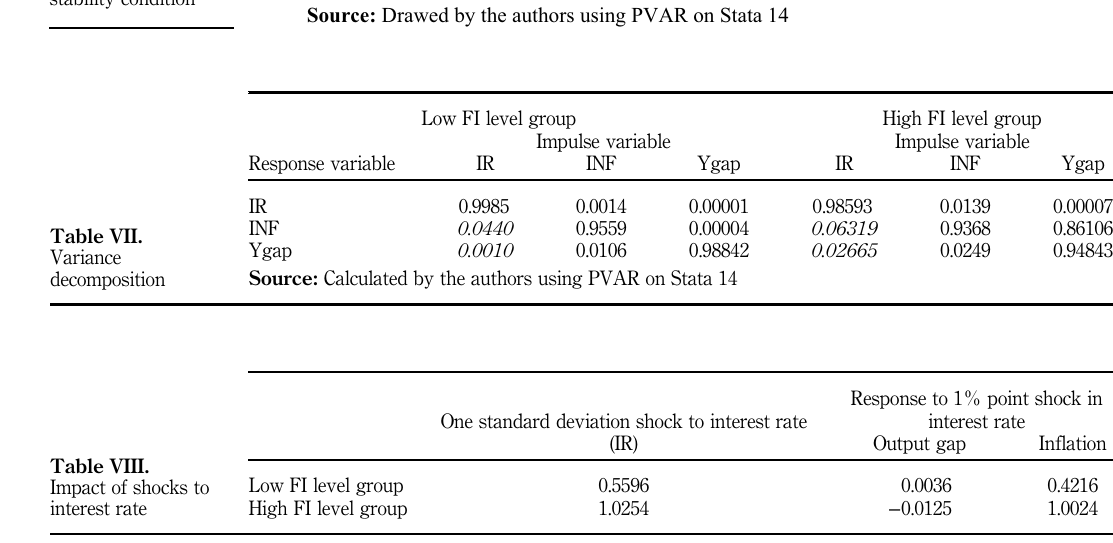
Figure 1. Graph of eigenvalue stability condition